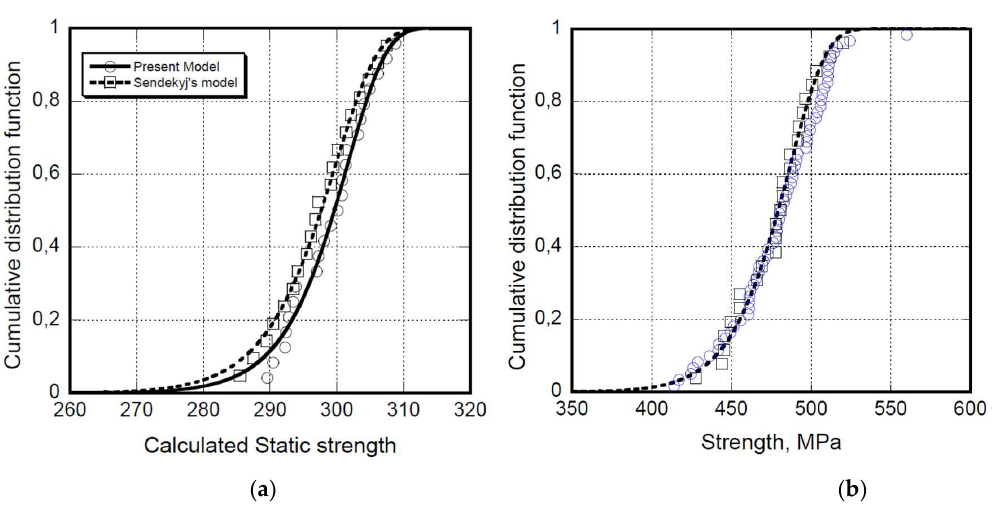
Figure 1. The cumulative distribution function for notched AS4 carbon / epoxy 3k / E7K8 Plain Weave Fabric-open hole specimens ( a ) and un-notched T700S / 2500 carbon / epoxy laminate with a (45 / 0 / -45 / 90) s lay-up ( b ). The Sendekyj’s and Caprino’s models’ equivalence in recovering the static strength from the fatigue life data is shown on the left. On the right, the square symbols represent the experimental static strength data, while the circles represent the nominal strength recovered from the fatigue data using the Caprino’s